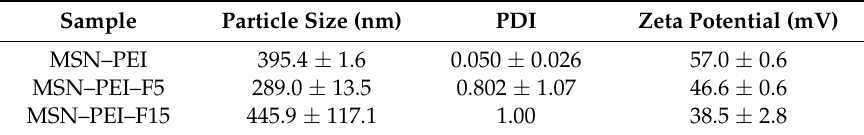
Table 2. Hydrodynamic particle size, polydispersity index (PDI), and ζ -potential of the drug-free and drug-loaded MSN–PEI suspensions (c = 0.2 mg/mL) in MQ/PG. The data is presented in triplicate ± StD.